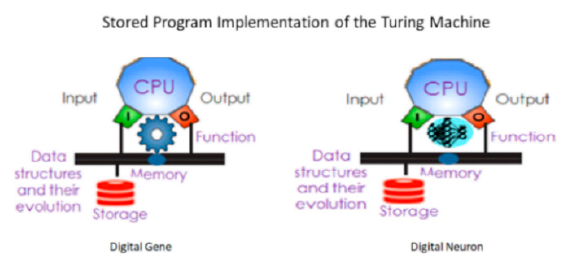
Figure 1. The Turing machine as a physical implementation of a cognitive apparatus with locality and the ability to form information processing